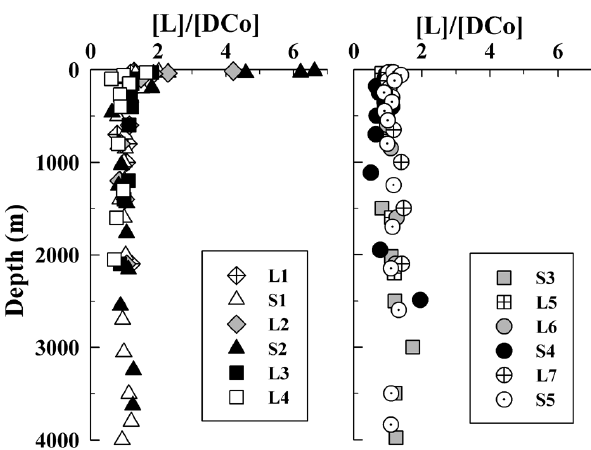
Fig. 4. Vertical distribution of L/DCo picomolar ratios in the subtropical and subantarctic domains (left panel), and in the po- lar frontal zone, the southern ACC and the northern Weddell Gyre (right panel).